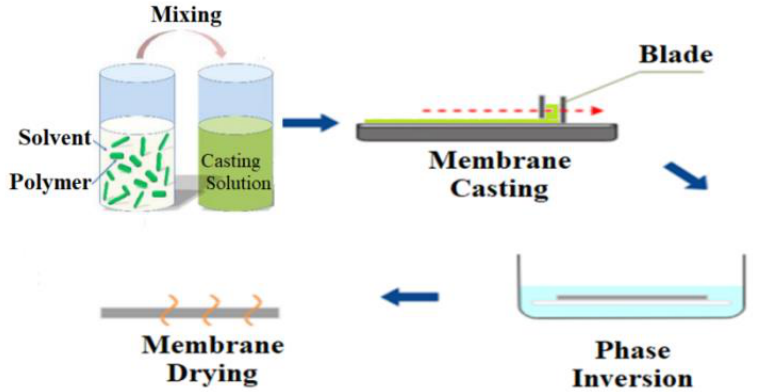
Figure 1. Modification of PSF membrane using the phase inversion method.